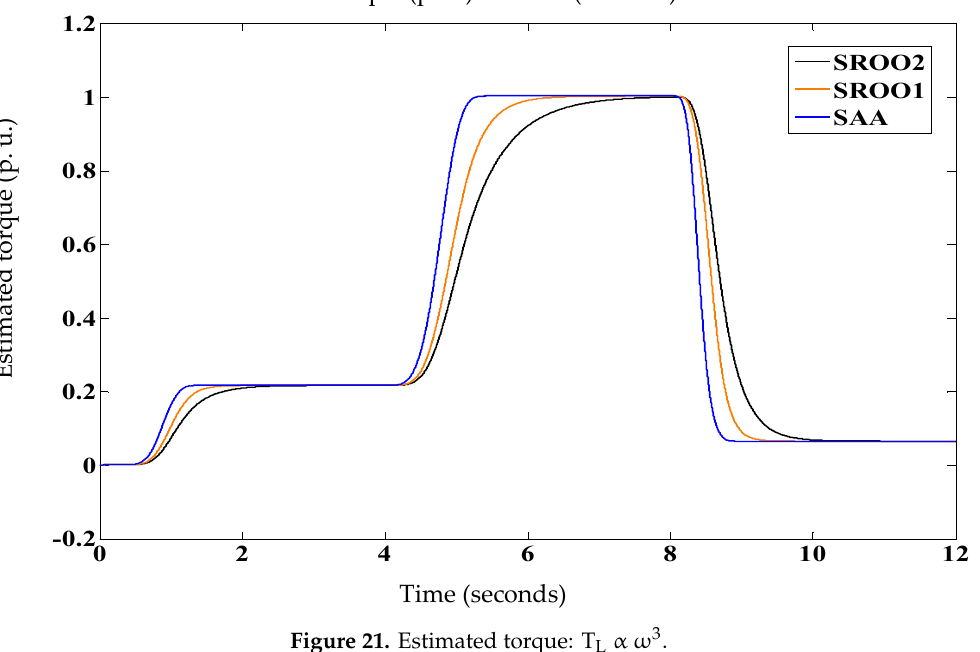
Figure 21. Estimated torque: T L α ω 3 .